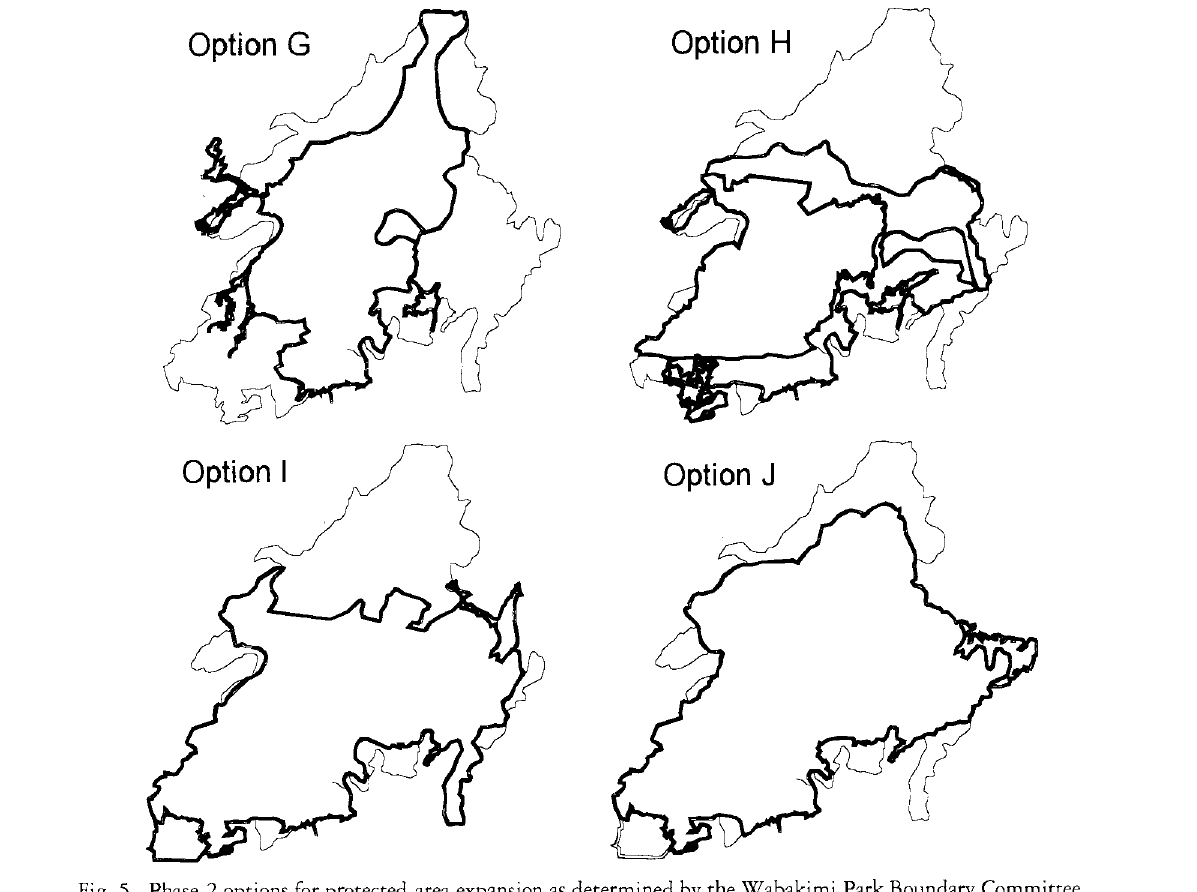
Fig. 5. Phase-2 options for protected-area expansion as determined by the Wabakimi Park Boundary Committee.